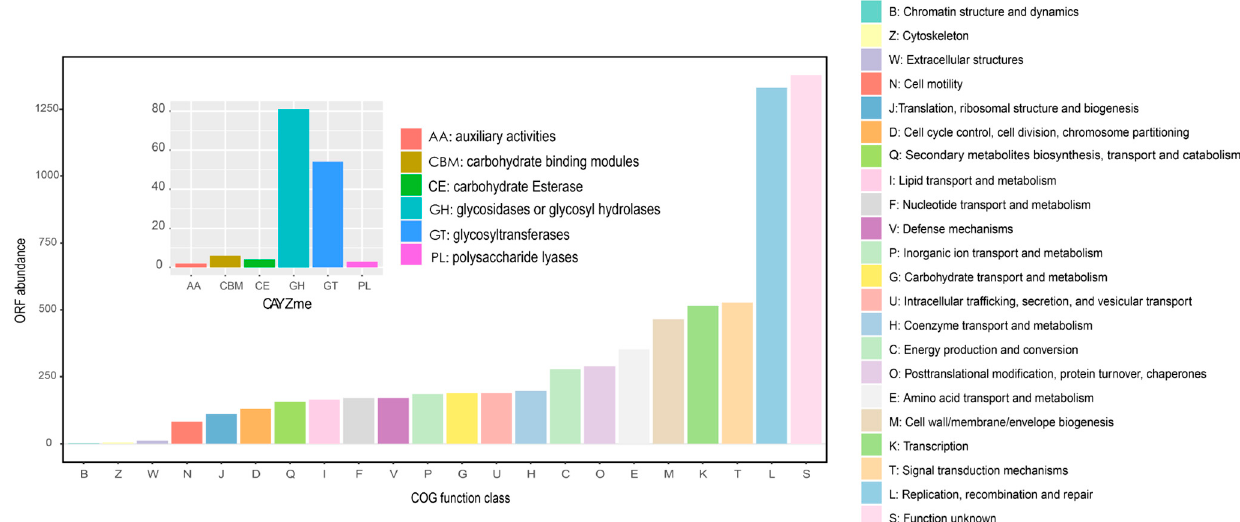
Figure 6. Annotation of viral genomes. COG annotation was performed using eggNOG-mapper. AMGs related to carbohydrate metabolism are illustrated in the inner panel.